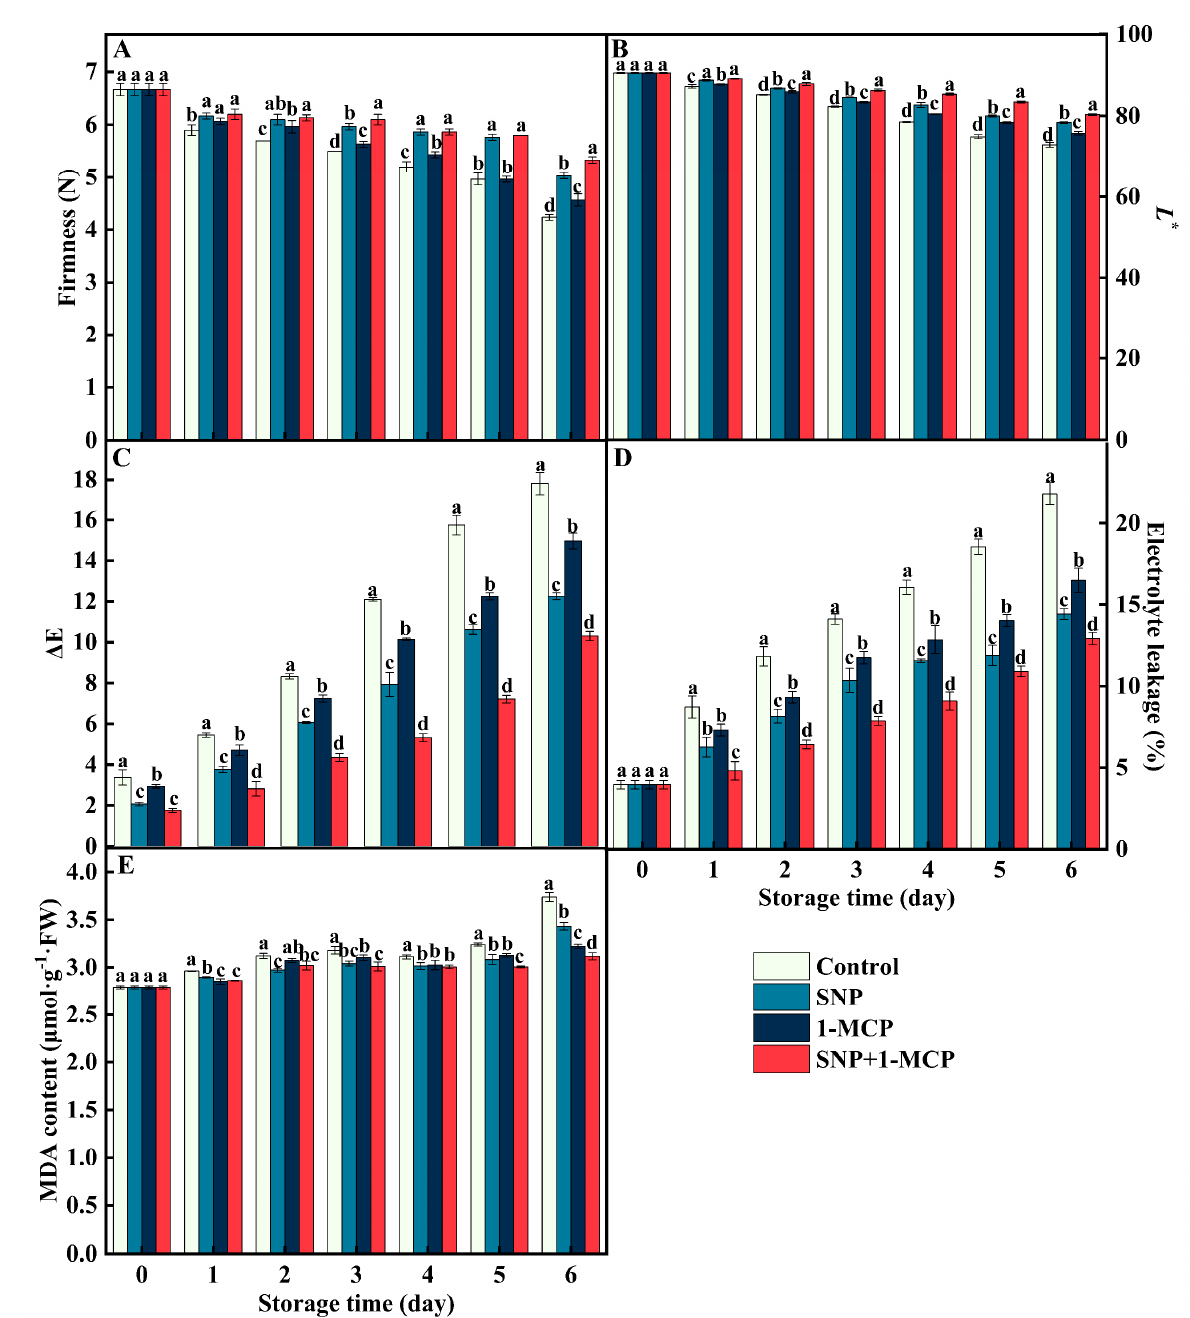
Figure 1. ( A ) Firmness, ( B ) L * , ( C ) ∆ E, ( D ) electrolyte leakage (EL), and ( E ) malondialdehyde (MDA) content of Agaricus bisporus at 25 °C. The letters indicate the significant difference ( p < 0.05), and the bars indicate standard error (means ± SE).